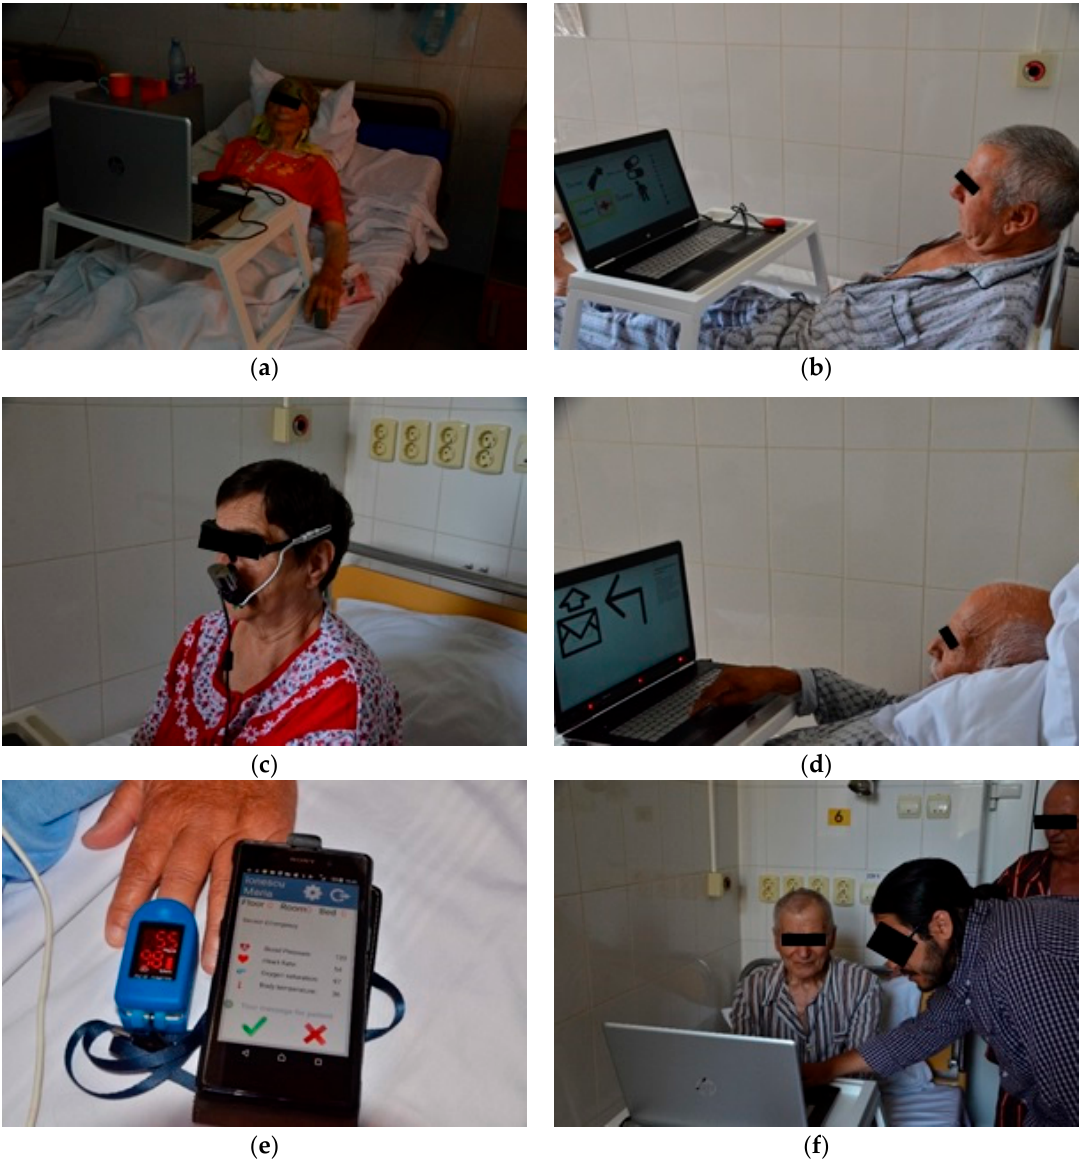
Figure 24. System testing on hospitalized patients at “Dr. C.I. Parhon” Clinical Hospital of Ia¸si, Romania. Testing the communication function based on a switch-type sensor ( a ), ( b ); using the head-mounted eye-tracking interface ( c ); using the remote eye-tracking interface ( d ); testing the telemonitoring function by the measurement of blood oxygen saturation and heart rate values and the transmission of these values to the caretaker device; ( e ) training the patients to use the system ( f ).